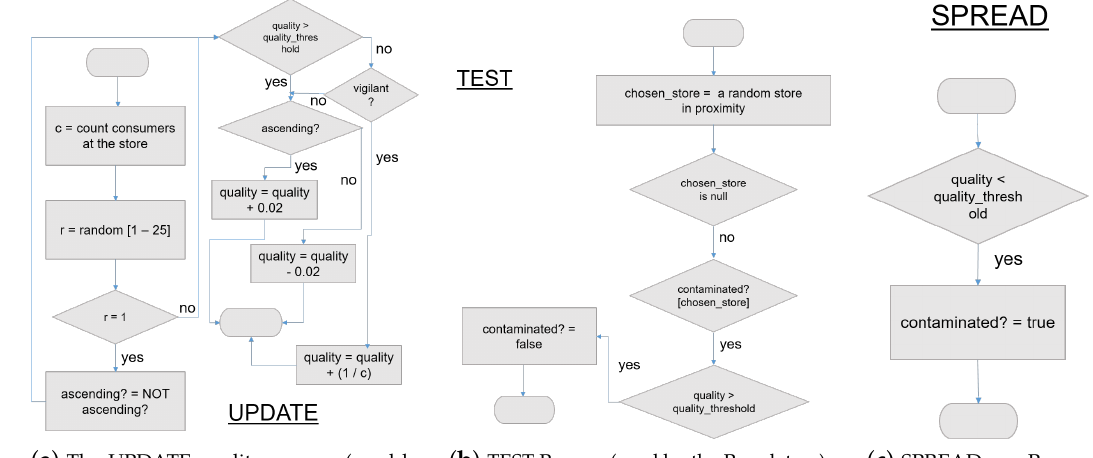
Figure 5. Current Model of Food Safety Inspections